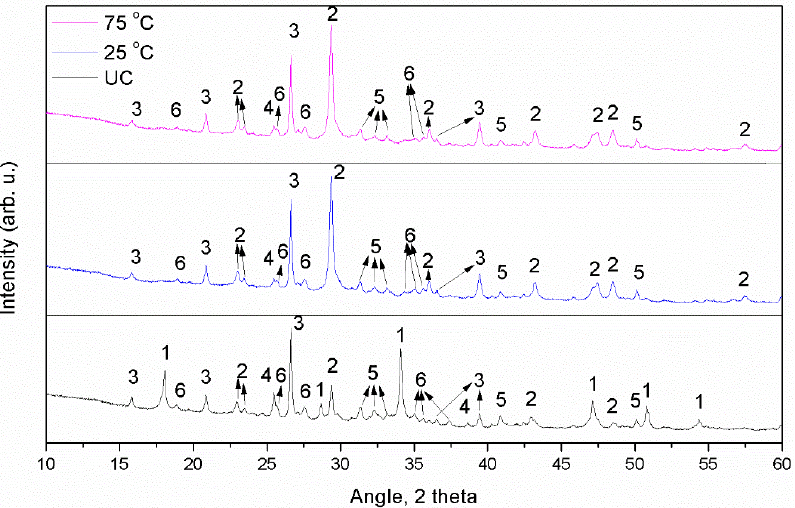
Figure 18. XRD patterns of OSA hydrated uncarbonated (UC), cured at 25 °C and 75 °C: 1 — Portlandite; 2 — Calcite; 3 — Quartz; 4 — Anhydrite; 5 — CSH; 6 — Ettringite.